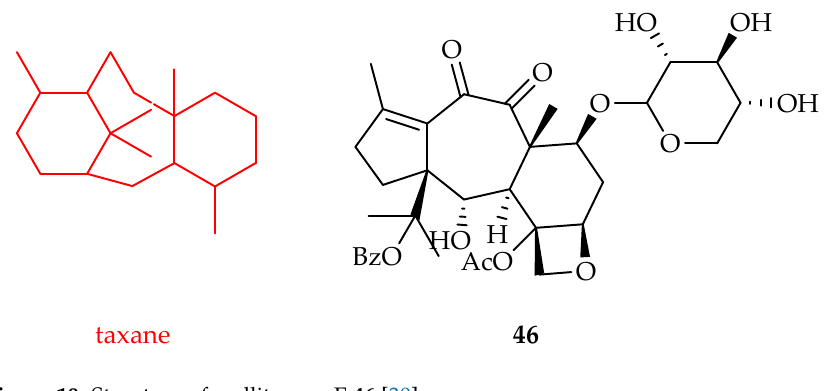
Figure 19. Structure of wallitaxane E 46 [30].